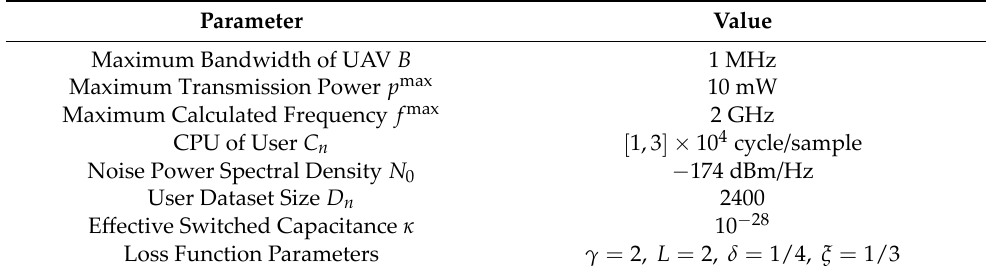
Table 2. Simulation